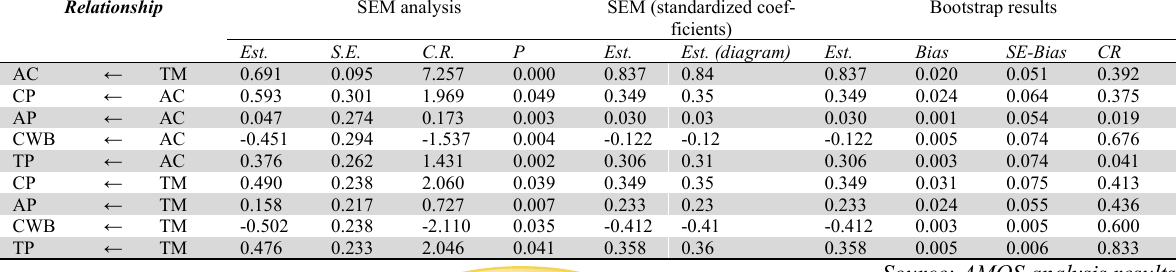
SEM analysis and coefficients